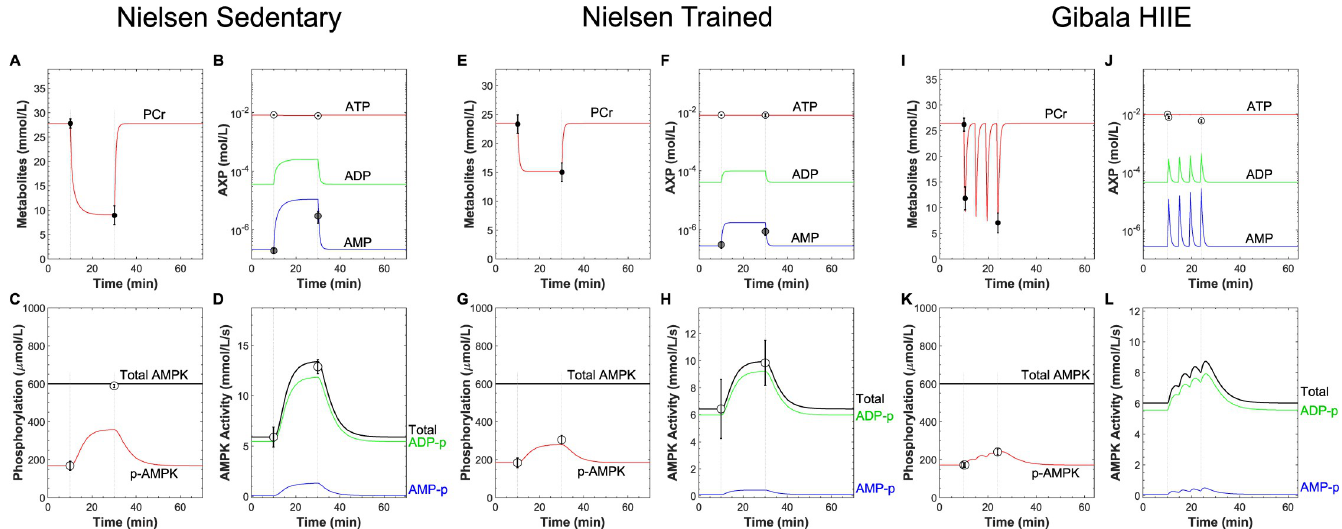
Fig 3. Model validation. The model predictions were compared to data collected from continuous cycling exercise performed by sedentary (panels A-D) or trained human participants (panels E-H) [41] and sprint-interval cycling exercise [6] (panels I-L). The hatched vertical lines indicate the times at which exercise was initiated and ceased. Data points and error bars represent the means ± standard error. A, E, I) Time courses of phosphocreatine (PCr) concentration. The filled circles represent the measured concentration. B, F, J) Semi-logarithmic plot showing the time courses of adenine nucleotide concentrations in response to exercise. The open and grey- filled circles represent the measured ATP and AMP concentrations, respectively. C, G, K) Time courses of total and phospho-AMPK (p-AMPK) levels in response to exercise. The open circles represent measured p-AMPK levels. D, H, L) Time courses of the simulated kinase activities for each AXP-p-AMPK complex. The open circles represent the mean relative change in total AMPK activities between rest and